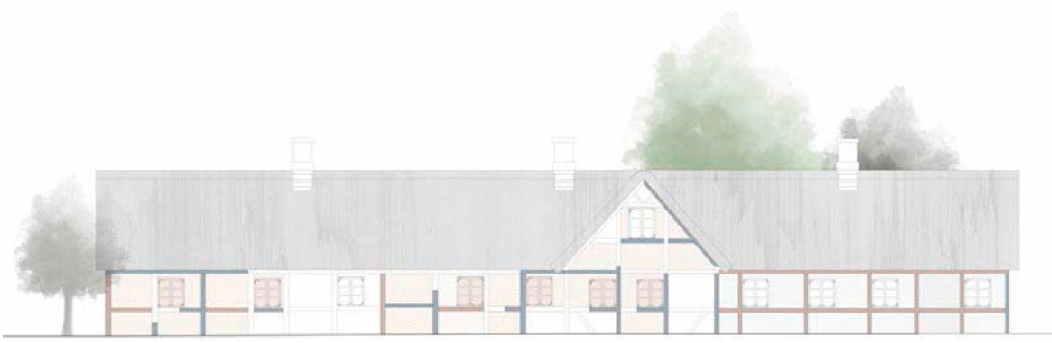
Figure 11. Analysis of usable and non ‐ usable elements in the restored wing of the historical farm building.